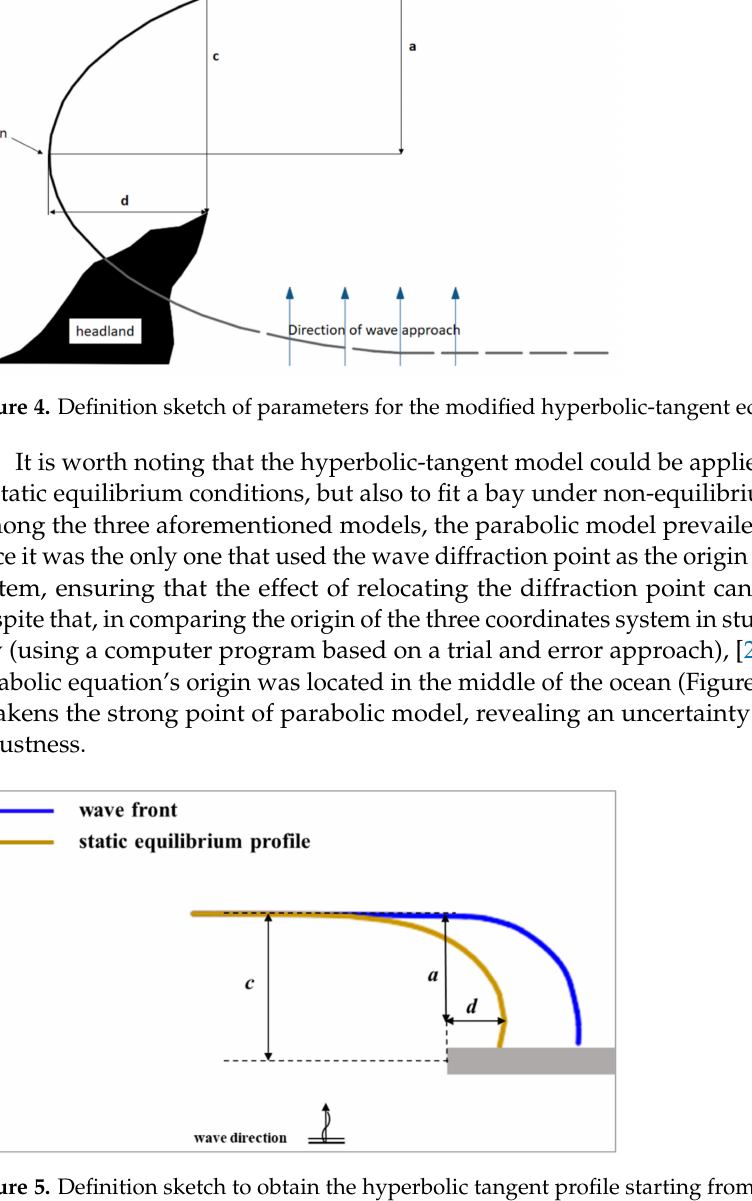
Figure 5. Definition sketch to obtain the hyperbolic tangent profile starting from a wave